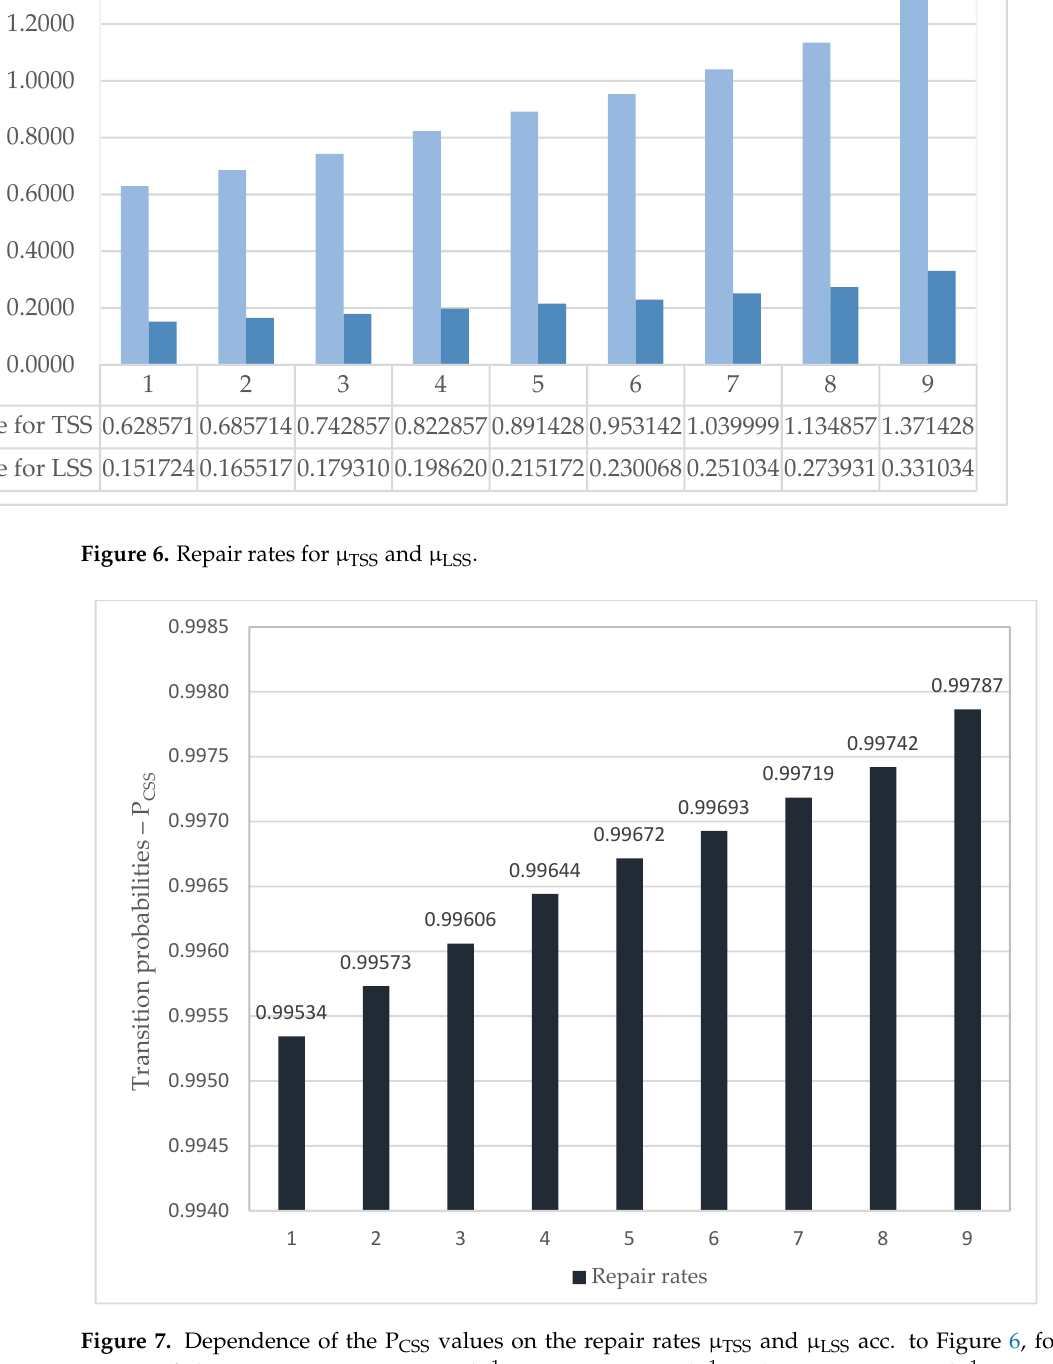
Figure 7. Dependence of the P CSS values on the repair rates µ TSS and µ LSS acc. to Figure 6, for constant failure rates λ CSS = 0.0028379 d −1 , λ TSS = 0.0007703 d −1 , and λ LSS = 0.0000220 d −1 .